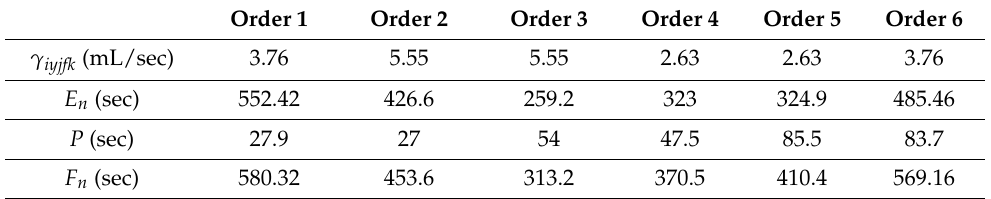
Table 7. The effect of change in length of conveyor belt on flavor feed rate and different times.